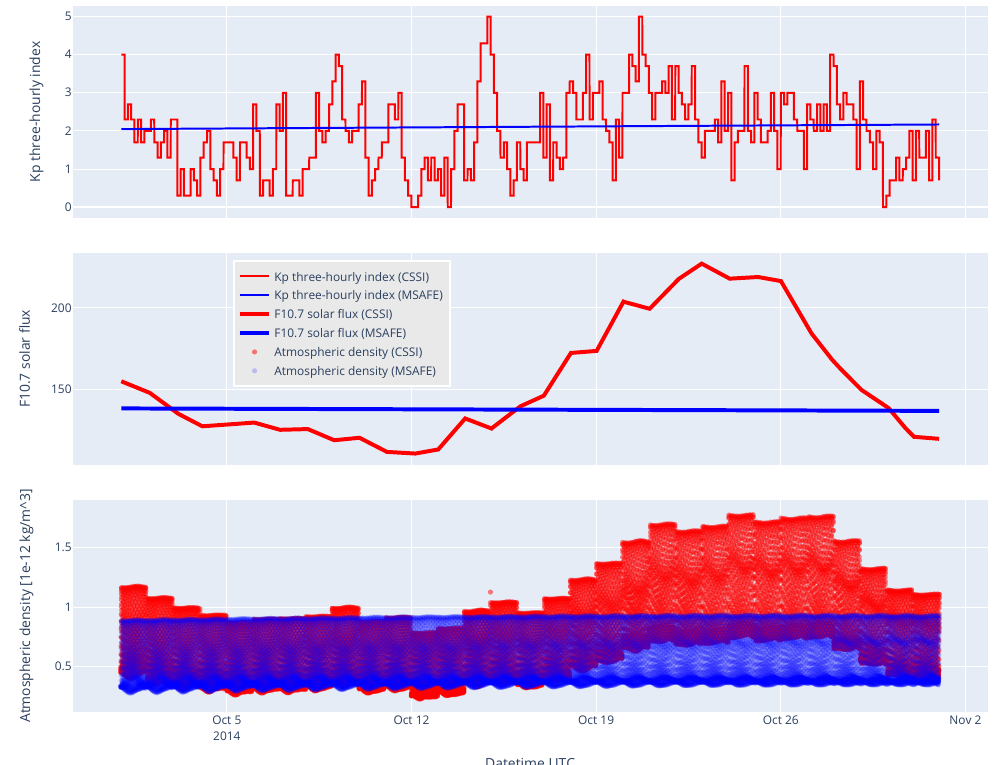
Figure 2. Comparison of data and atmospheric density from the CSSI and MSAFE space weather files for an SSO orbit at a 515km altitude with an 18h local time of ascending node (LTAN). ( Top ) Three- hour Kp geomagnetic index. ( Middle ) F10.7 daily solar flux (interpolated). ( Bottom ) NRLMSISE-00 atmospheric density model resulting from both data